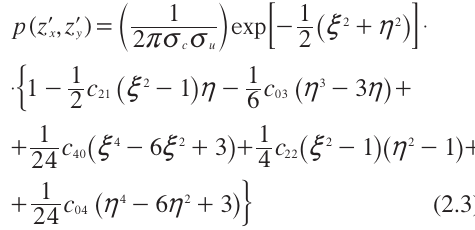
while p and h are the normalized x and y slopes defined as